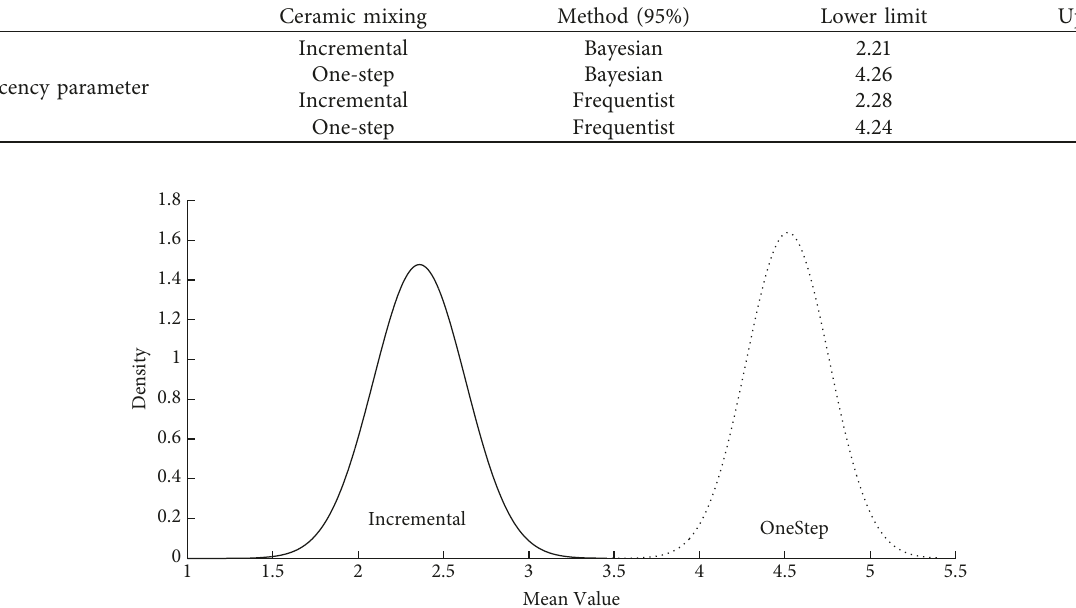
Figure 2: Posterior distribution for the overall mean TP ( μ ) in the highest probability intervals and the mean TPs ( μ and one-step (B μ ) mixing methods. 2